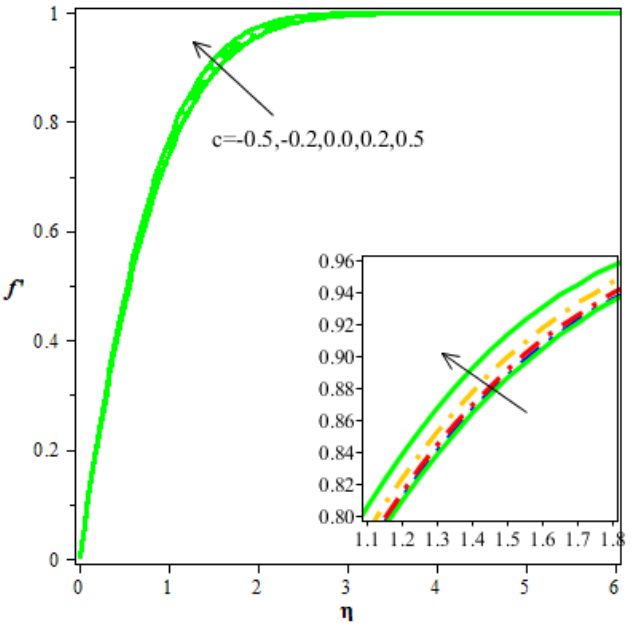
Figure 3. The curve f (cid:48) ( η ) on c . Figure 3. The curve